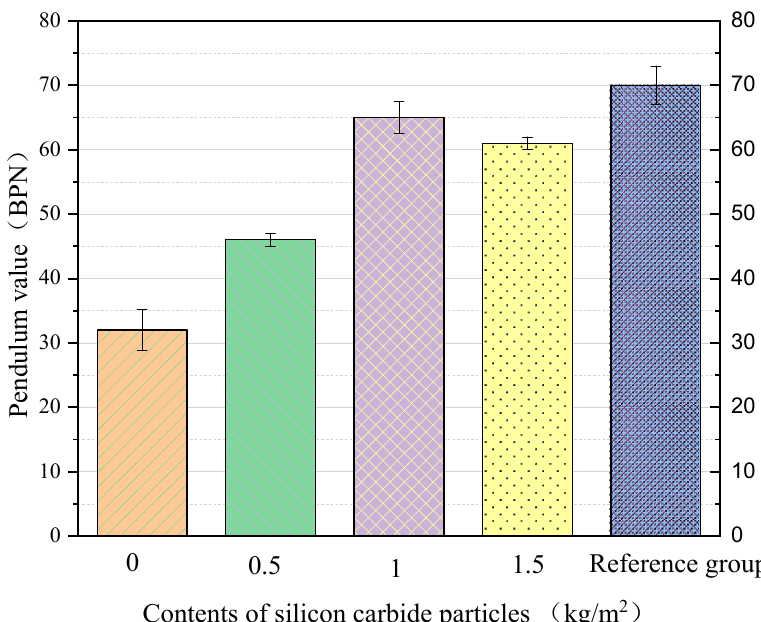
Figure 14. BPN contrast for the four kinds of surfaces and the uncoated surface.